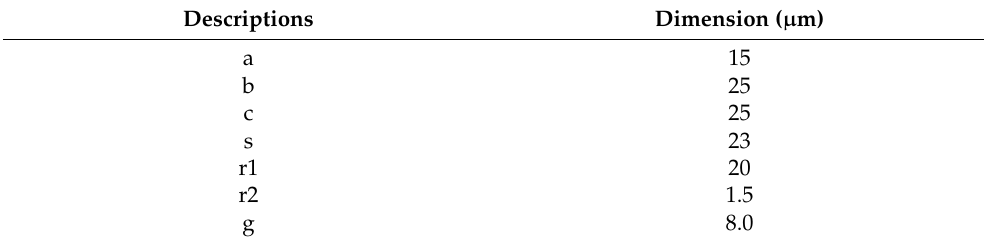
Table 1. Dimension of both